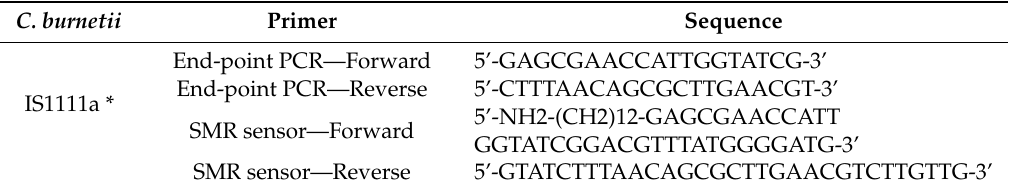
Table 2. Primer sequences of C.